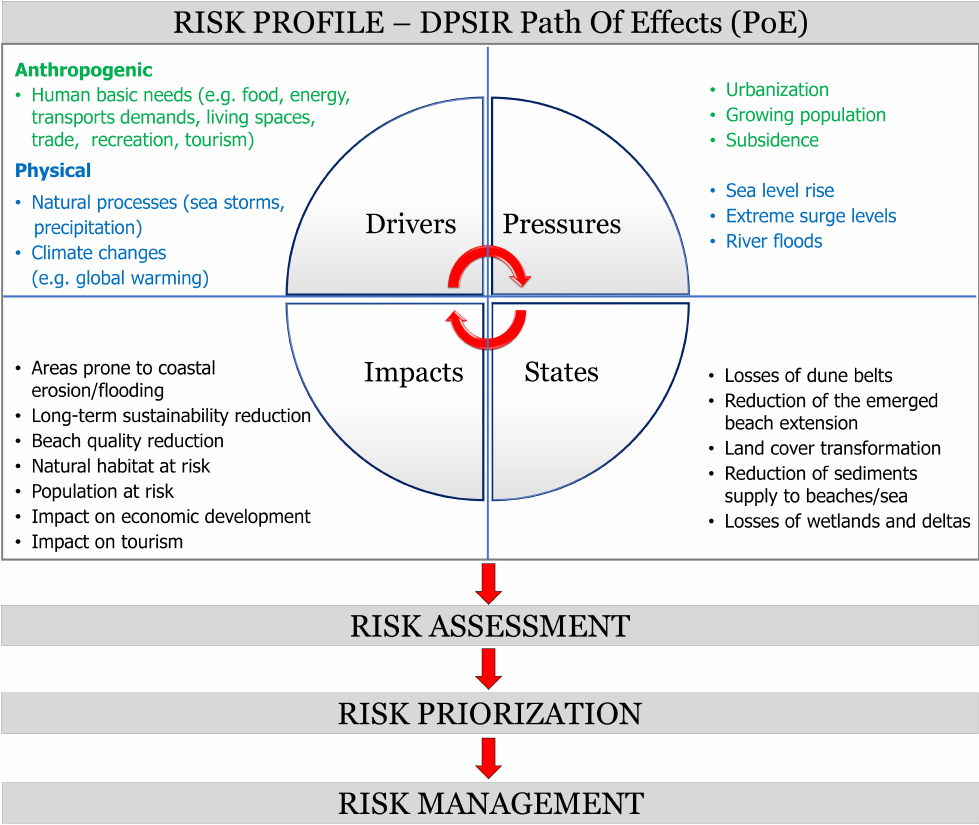
Figure 3. Path of Effects (PoE)-based risk assessment